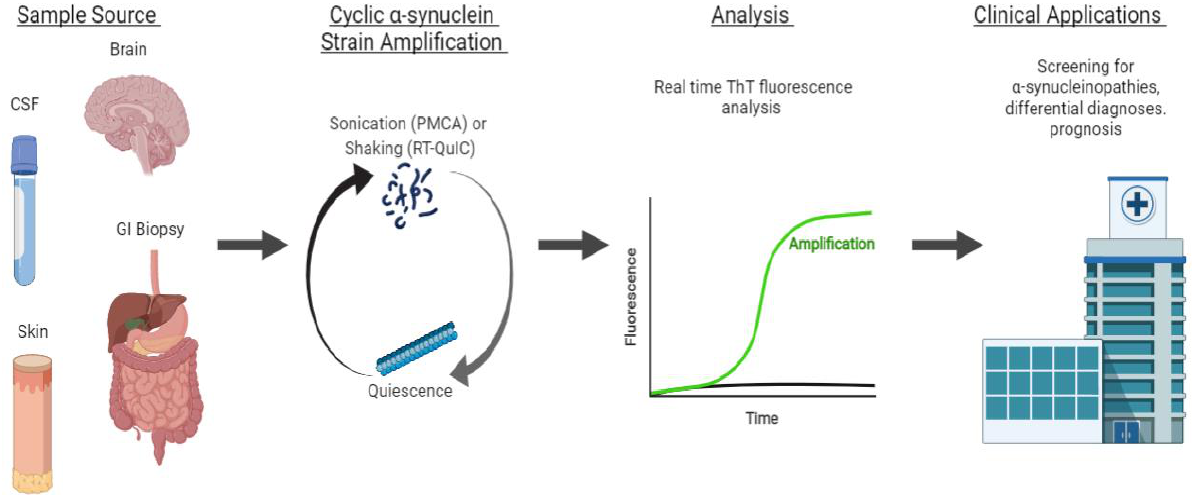
Figure 3. Strain amplification assay for αS. Sample sources include the brain, cerebrospinal fluid (CSF), skin, and gastrointestinal (GI) biopsies. From the sample, αS fibrils are amplified in cycles of sonication (PMCA) or shaking (RT-QuIC) to make polymerization points available for the misfolding of wild-type proteins. The sonication and shaking periods are followed by a period of quiescence, where the fibrils aggregate and polymerize. This process is cyclically repeated to amplify misfolded proteins to detectable levels that are analyzed by the real-time monitoring of ThT fluorescence. This technique can be applied clinically for the early screening, differential diagnoses, and prognosis of α -synucleinopathies.